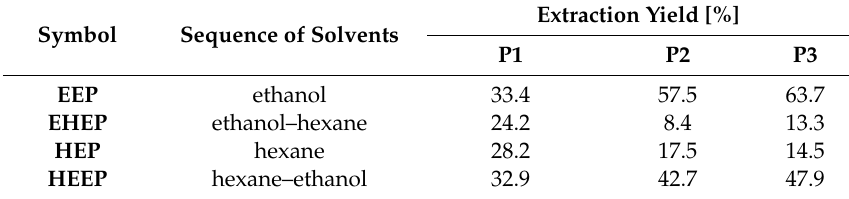
Table 1. Extraction yields of the prepared extracts; P1—propolis from Podlasie, P2—propolis from Masovia, P3—propolis from West Pomerania Province, EEP—ethanol extract of propolis, EHEP—